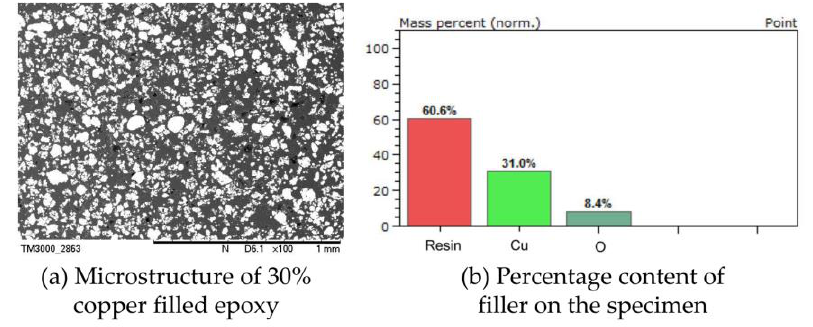
Figure 6. Optical micrographs of the 30% copper filled epoxy.